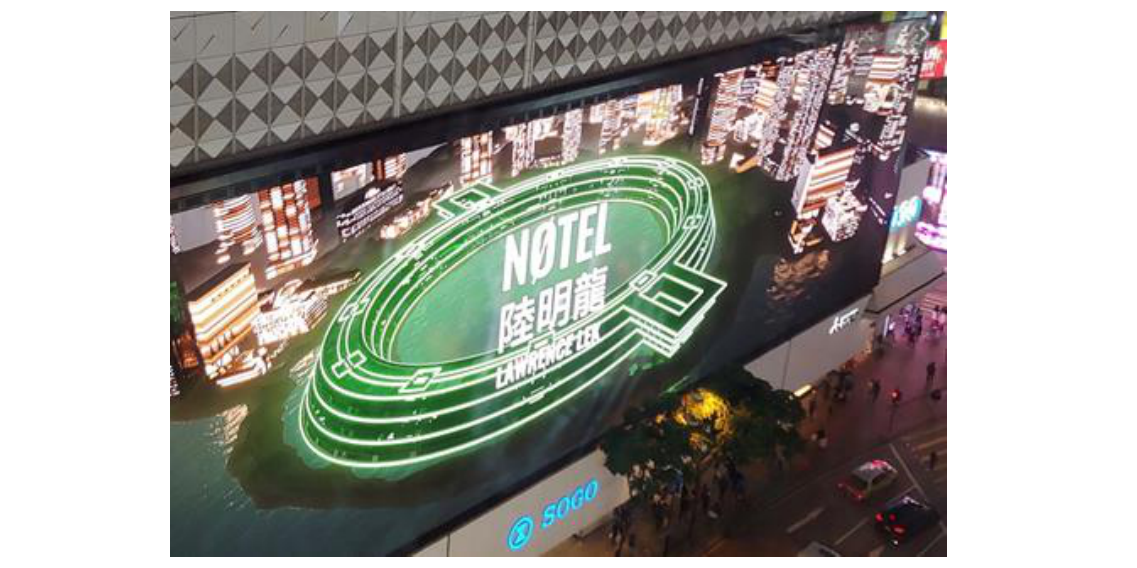
Figure 3 Nøtel, Hong Kong, China (Source: Videotage,